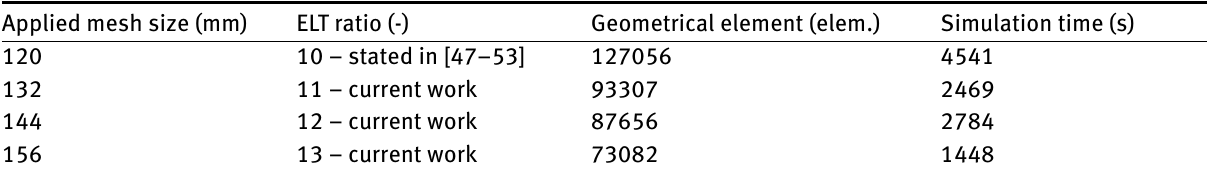
Table 4: Summary of simulation times for all applied mesh sizes Applied mesh size (mm) ELT ratio (-) Geometrical element